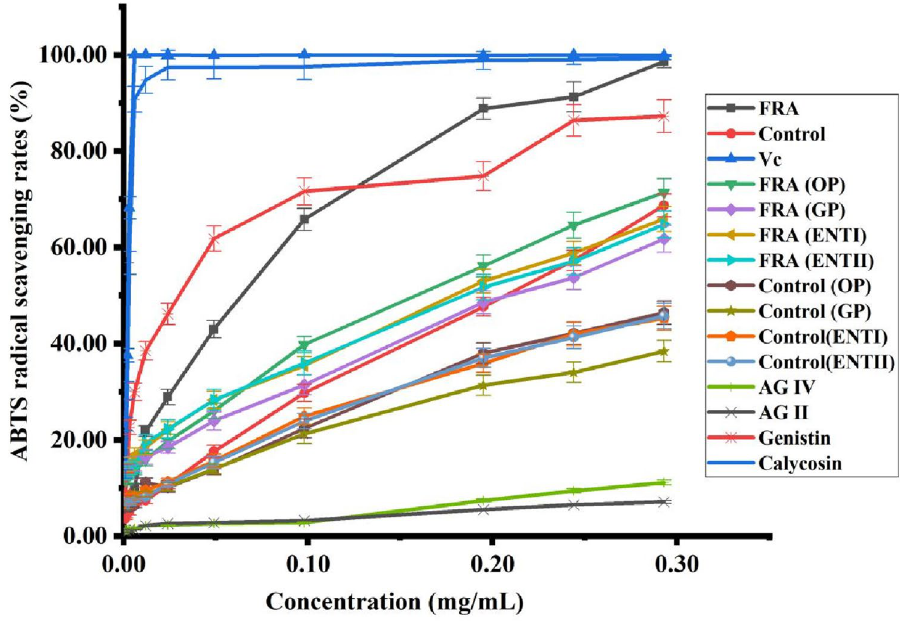
Figure 4. ABTS radical scavenging rate of each sample of Radix Astragali, standards and